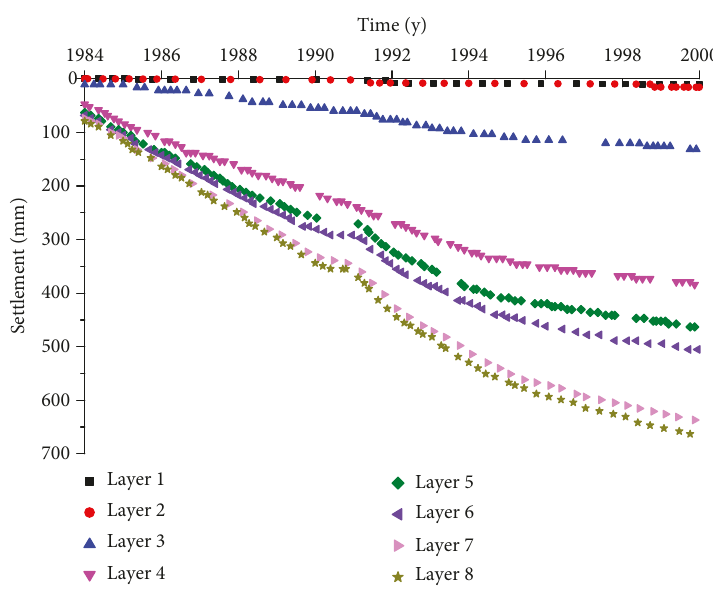
Figure 6: Settlement records of the Changzhou Qingliang primary